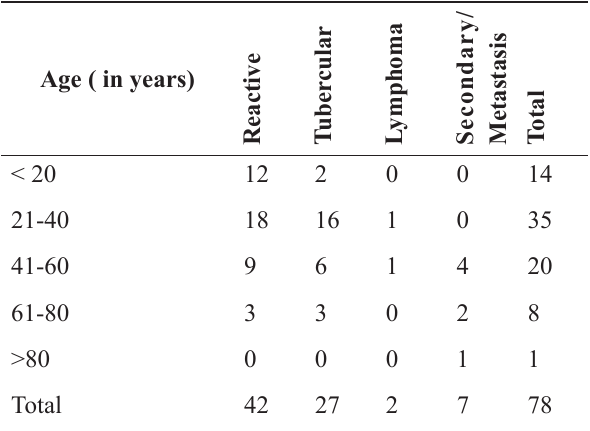
Table 3: Age-wise distribution of the pattern